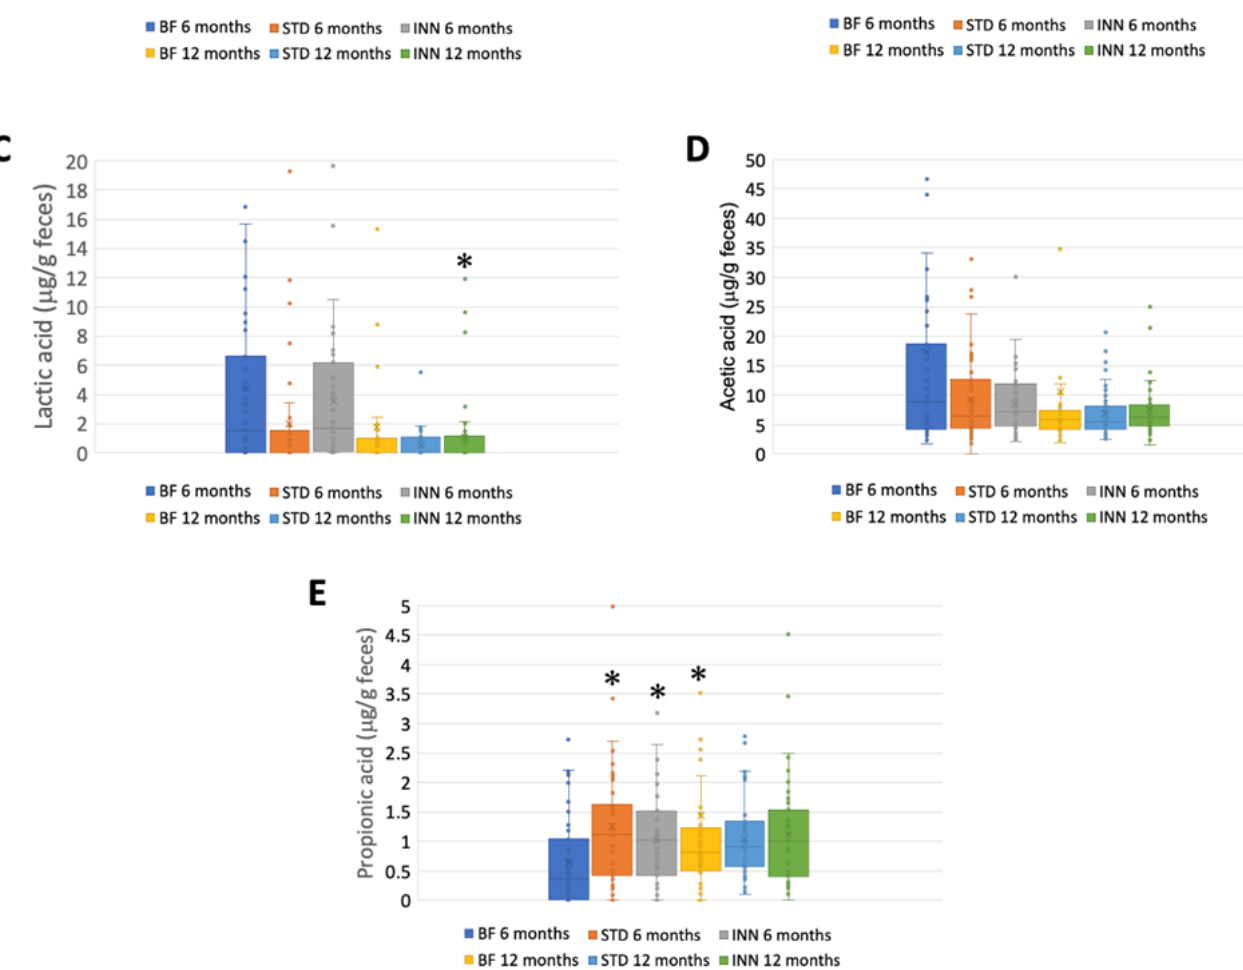
Figure 2. Calprotectin, IgA, and SCFAs. ( A ) Calprotectin (mg/kg). ( B ) Immunoglobulin A (μg/g). ( C ) Lactic acid (μg/g feces). ( D ) Acetic acid (μg/g feces). ( E ) Propionic acid (μg/g feces). * p < 0.05, significant differences were calculated with an independent sample median test adjusted by the Bonferroni correction for multiple